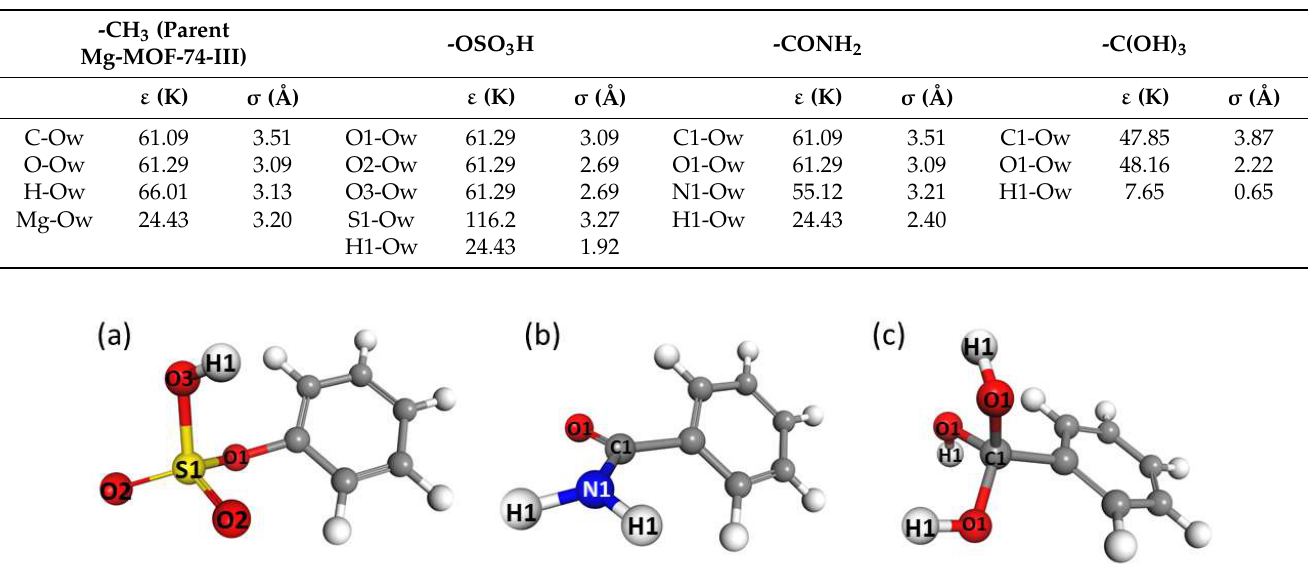
Figure 4. Comparison between the interaction energy curves for H 2 O molecules around the parent and modified linkers of this study. Interaction energies were calculated using MP2 (filled symbols), unfitted Lennard–Jones potentials (dashed line) and fitted Lennard–Jones potentials (solid lines). The inset figure in each case shows the orientation along which the binding energies were calculated. Table 3. Lennard–Jones parameters for the framework atoms corresponding to parent (-CH 3 ) and functionalized Mg-MOF-74-III.